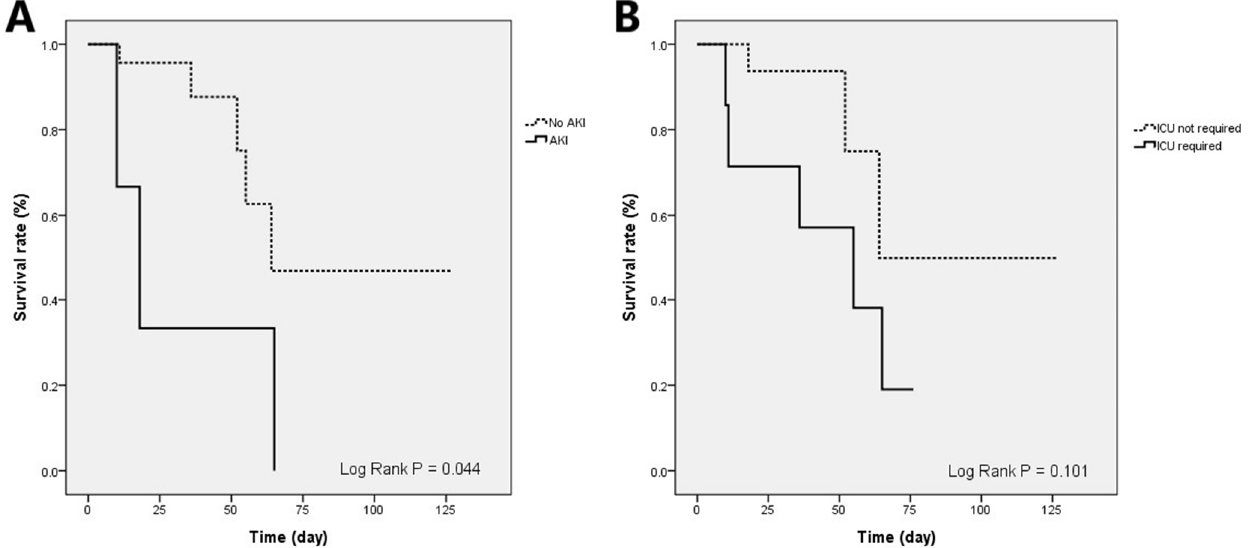
Figure 3. Kaplan–Meier survival curve analysis of patients with CMV esophagitis . ( A ) Patients with AKI (solid line) had a significantly worse survival rate than those without AKI (dash line) (log-rank p = 0.044). ( B ) Patients who required ICU care had a worse survival rate, although it was not statistically significant (log-rank p = 0.101). AKI—acute kidney injury; CMV—cytomegalovirus; ICU—intensive care unit.